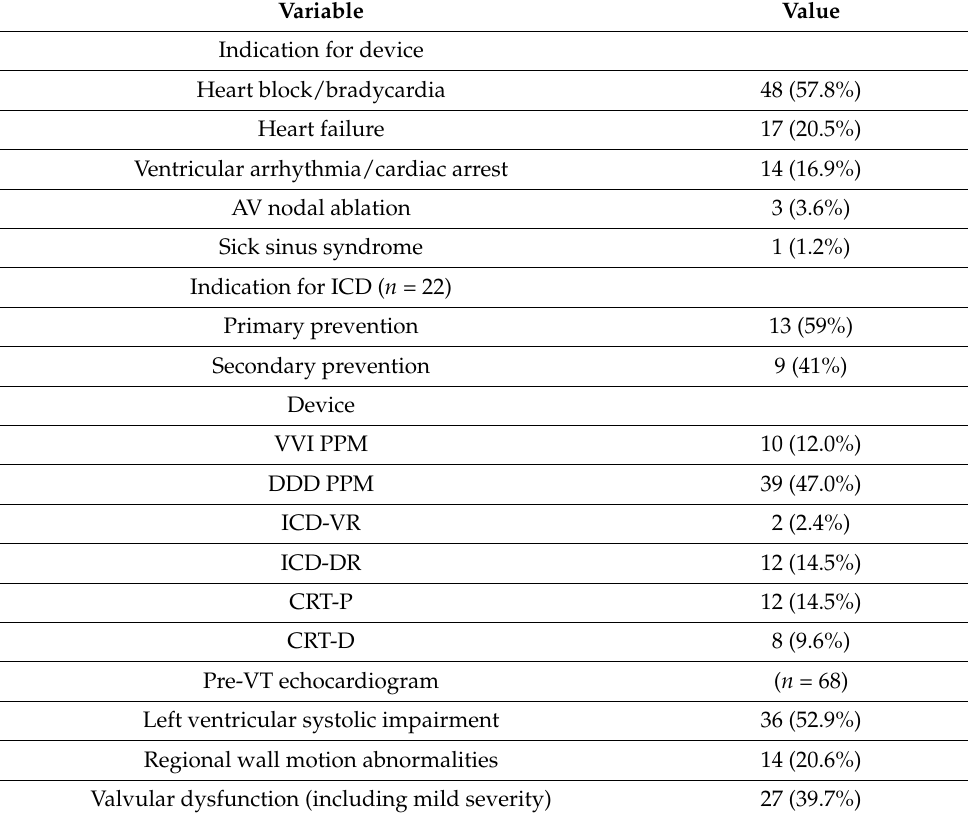
Table 2. Device and pre-ventricular tachycardia